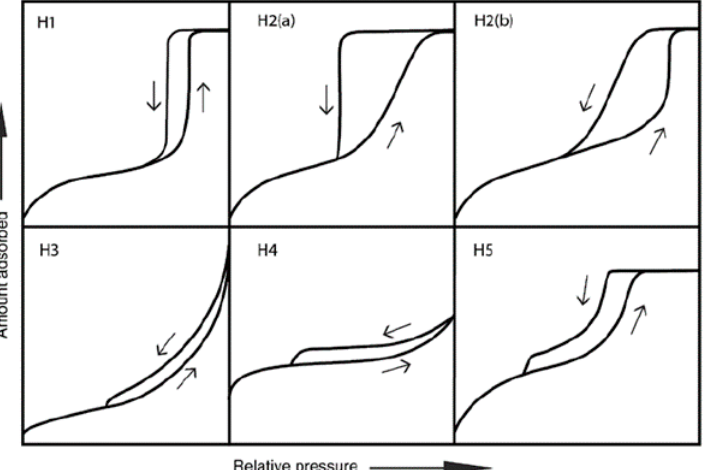
Figure 6. Updated classification of hysteresis loops by IUPAC 2015 [48]. The Type H1 loop indicated for uniform mesopores materiarls (e.g., MCM-41, MCM-48, SBA-15), the Type H2(a) loop indicated for pore-blocking with narrow neck sizes (e.g., vycor., SBA-16 and KIT-5 silicas), the Type H2(b) loop indicated for pore-blocking with larger neck sizes (e.g., MCF), the Type H3 loop indicated for non-rigid aggregates of plate-like particles (e.g., certain clays), and the Type H4 loop indicated for aggregated crystals of zeolites and micro-mesoporous carbons. The Type H5 hysteresis loop indicated for plugged SBA-15 materials.